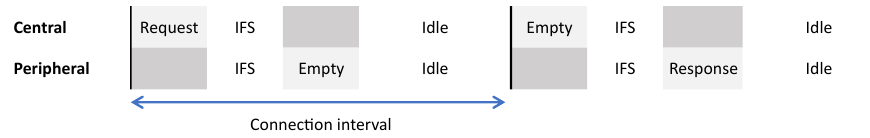
Figure 4. Typical discovery request and